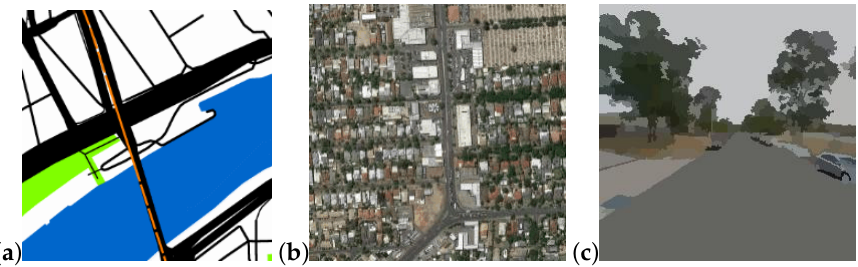
Figure 1. Sample neural network training images for ( a ) GM (from Paris, France [51]), ( b ) GS (from Adelaide, Australia [51]), and ( c ) for GSV-BSV after mean shift pre-processing (from Sydney, Australia